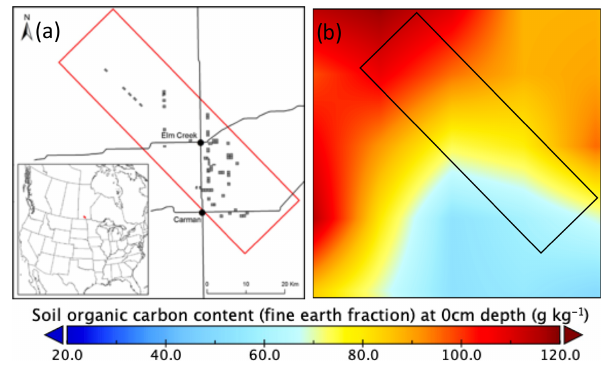
Figure 2. (a) SMAPVEX12 validation sites (adapted from Row- landson et al., 2013) and (b) calculated distribution of soil organic matter in Canada based on the SoilGrid250m